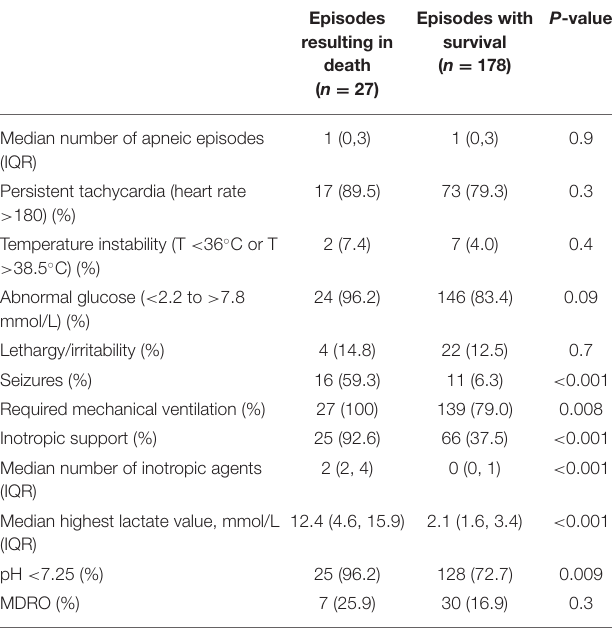
TABLE 3 | Clinical course during late onset sepsis episodes stratified by those with survival and those resulting in death ( n = 205).